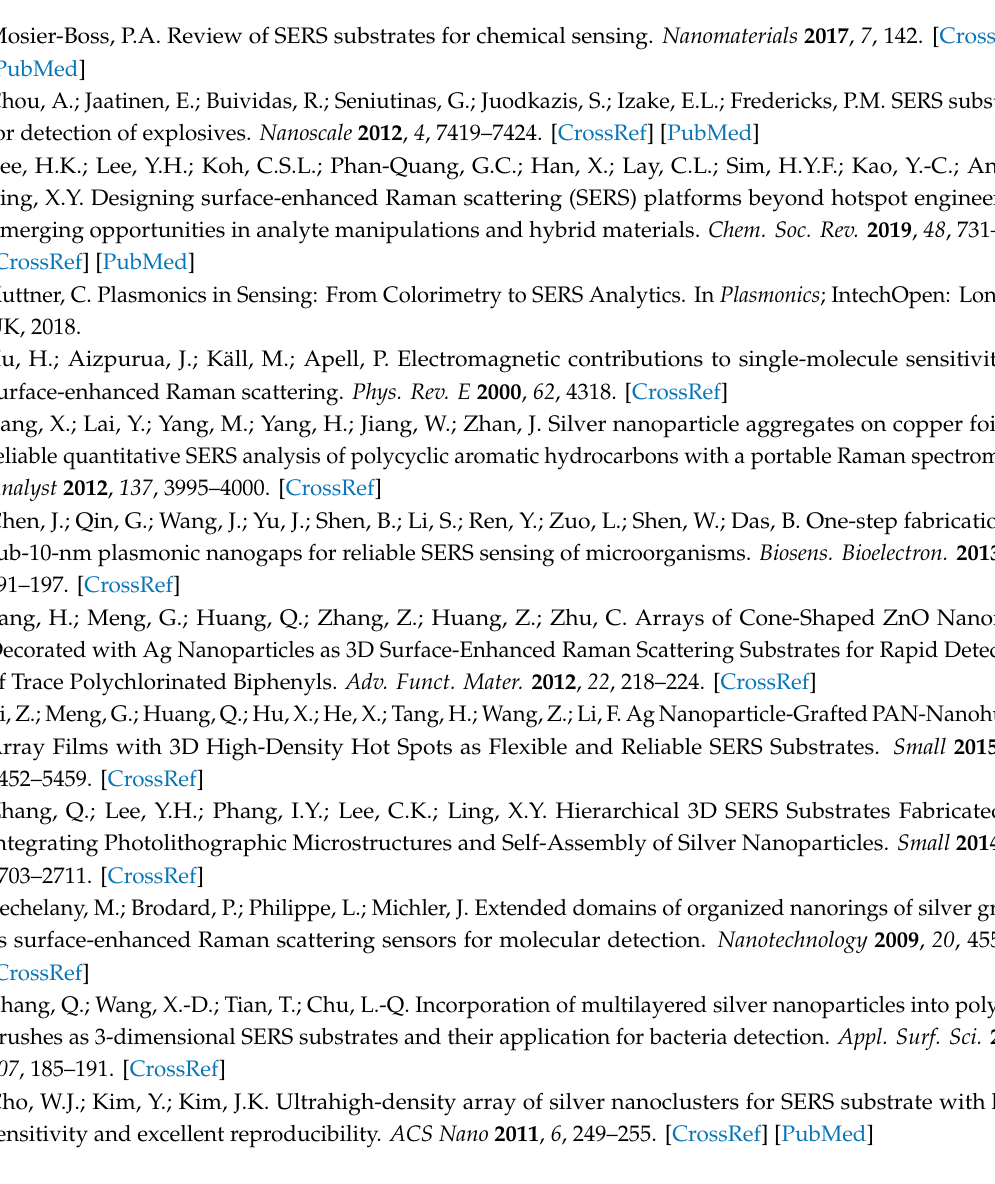
Figure S1: MeSA Raman spectra from KnowItAll software, Figure S2: SEM images of the transferred AgNSs, Figure S3: XPS spectra of the